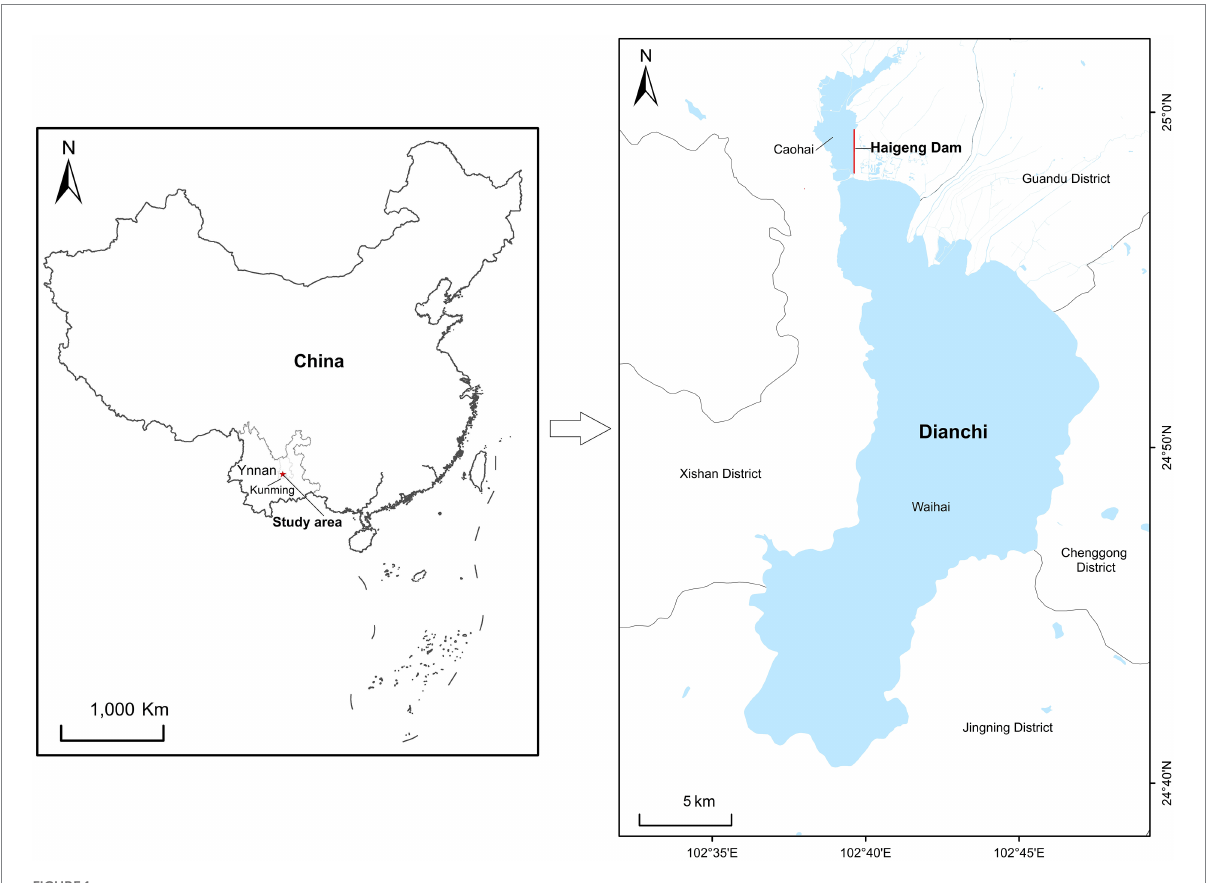
FIGURE 1 Study area in Dianchi Lake, Kunming City, Yunnan Province, southwestern